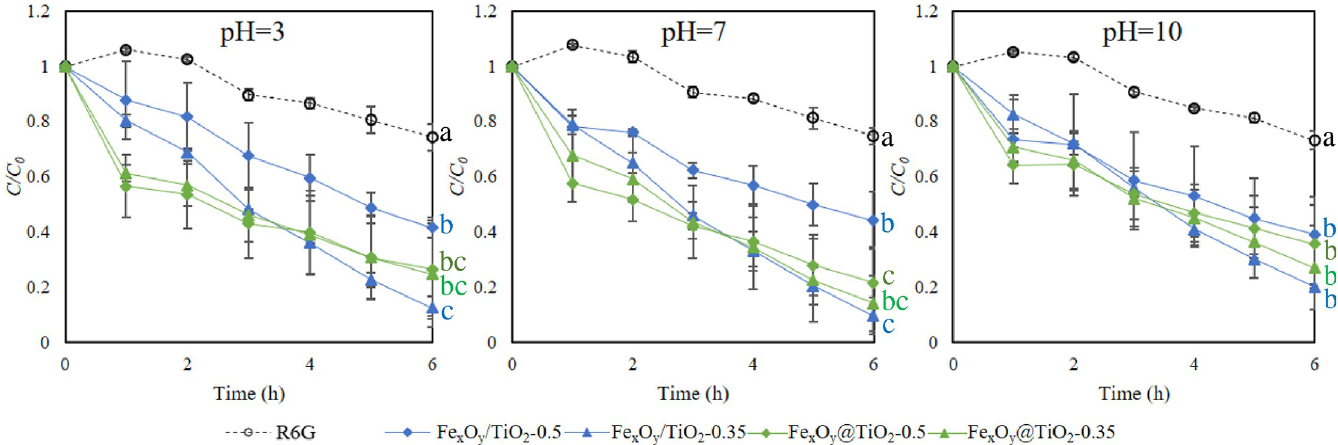
Fig 4. Impacts of pH on R6G photocatalysis performance. (A) pH = 3, (B) pH = 7, (C) pH = 10. Dotted lines represent the change of R6G concentration under UV- irradiation without magnetic-TiO 2 -nanocomposites, and solid lines represent R6G photodegradation dynamics under UV-irradiation with magnetic-TiO 2 - nanocomposites. Experimental conditions: UV-irradiation, 253 nm (20 W); magnetic-TiO 2 -nanocomposites concentration, 0.4 g/L; initial R6G concentration, 10 mg/L. Different small letters after each line indicate significant difference (Duncan’s test, p < 0.05) among treatments (n = 3).